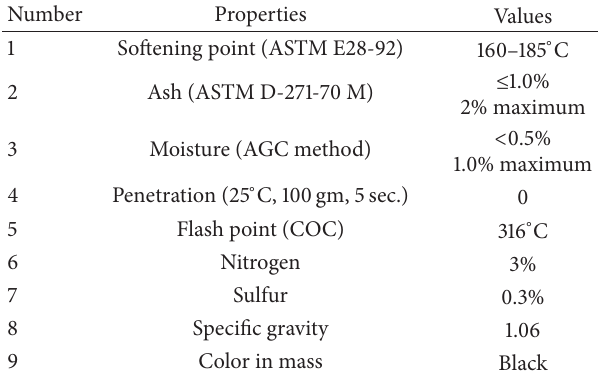
Table 3: Properties of Gilsonite HMA modifier grade